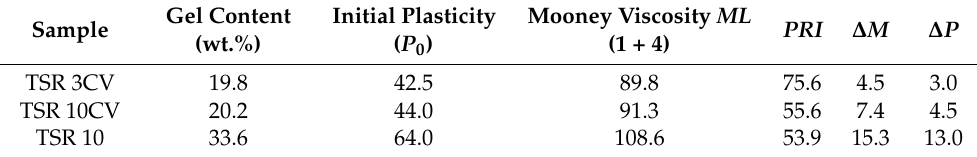
Table 3. Structure parameters of un-vulcanized NR for TSR 10, TSR 10CV and TSR